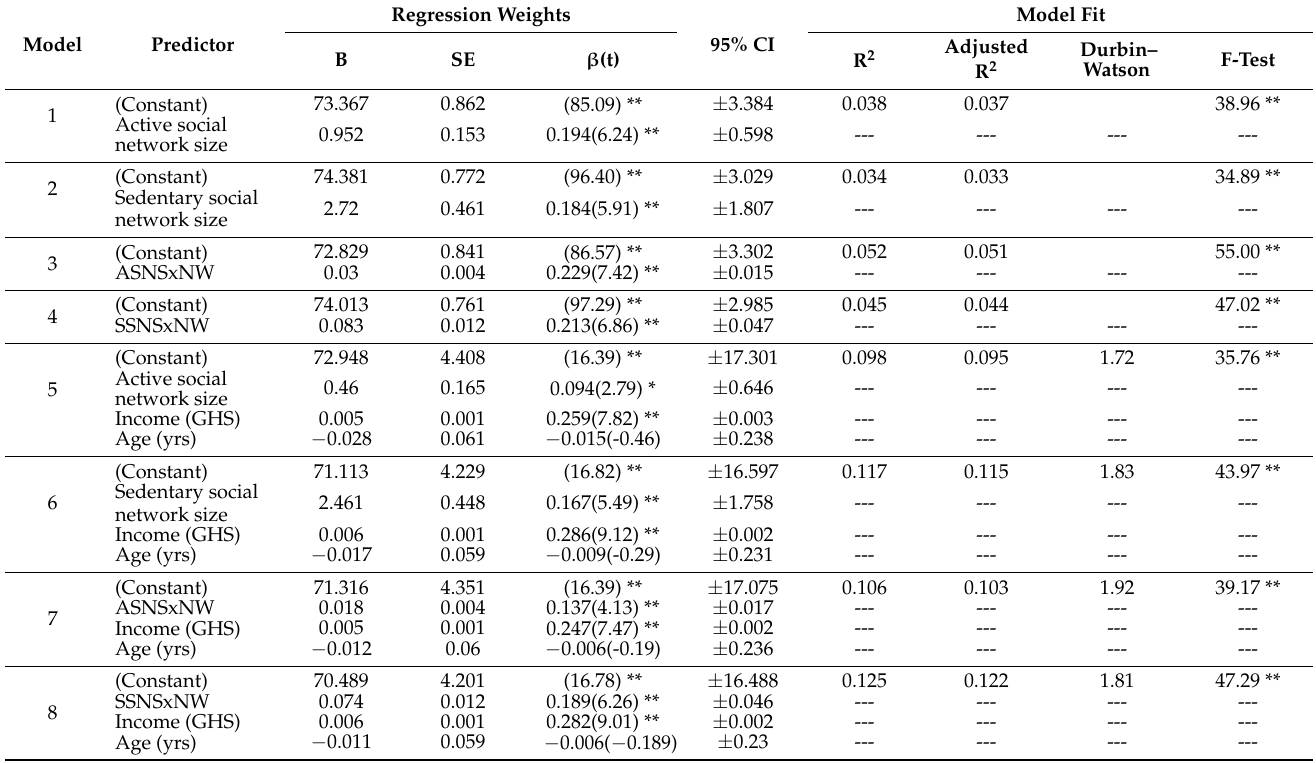
Table 3. The associations between active social network size, sedentary social network size, physical activity enjoyment, and walkability (n =